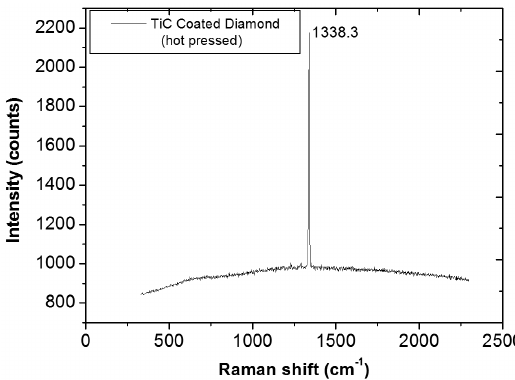
Figure 4. Raman spectroscopy of diamond crystals as received from the manufacturer.